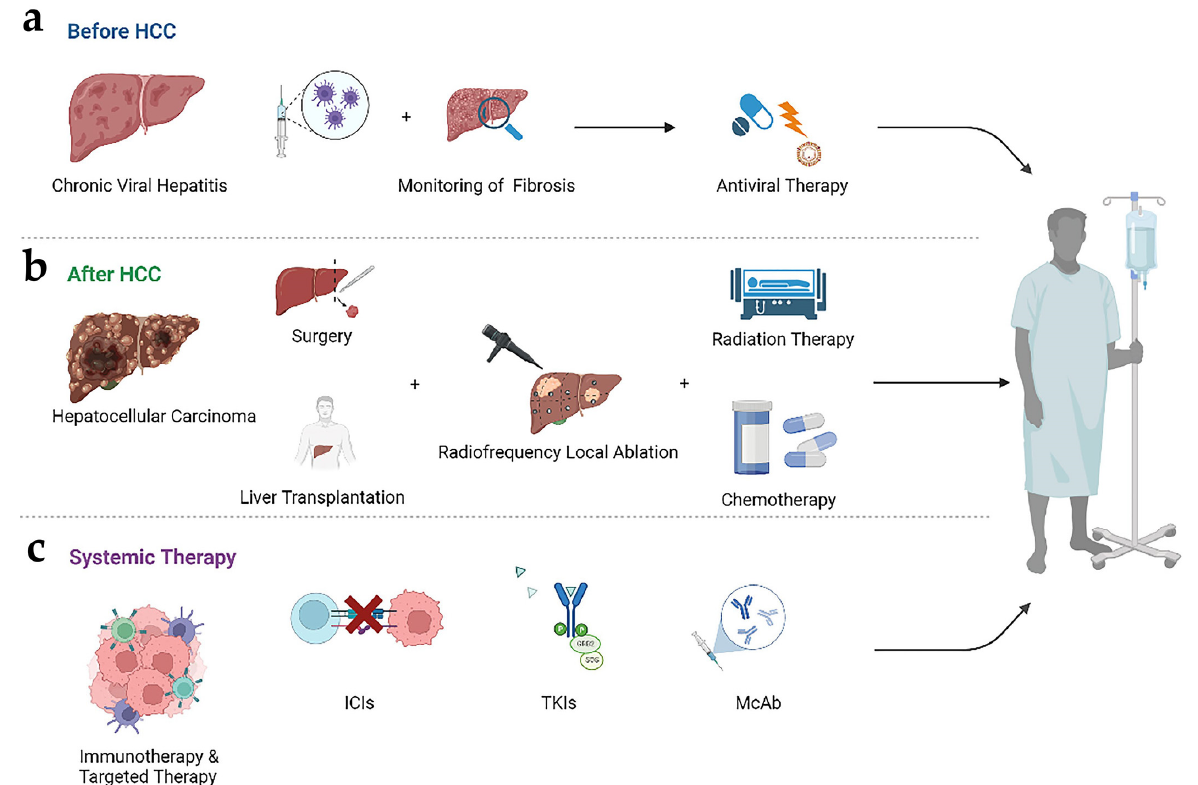
Figure 3. Management and treatment of HBV-induced HCC. ( a ) The main measures before HCC are active HBV vaccination and the continuous detection of the progression of liver fibrosis. For patients with chronic HBV infection, antiviral therapy should be actively carried out to prevent the further development of viral hepatitis. Chronic HBV infection refers to an HBV-positive test, the course of the disease being more than half a year or the onset date not being clear, and clinical manifestations of chronic hepatitis [94]; ( b ) The treatment of HCC includes surgical and non-surgical methods. The surgery includes liver resection and liver transplantation. Non-surgical methods include radiofrequency local ablation, chemotherapy, and radiotherapy [88]; ( c ) Systemic therapies, including immune checkpoint inhibitors (ICIs), tyrosine kinase inhibitors (TKIs), monoclonal antibodies (McAbs) and other targeted molecular drugs, can better achieve personalized treatment, especially to improve the survival rate of advanced patients who cannot be treated with surgery. The image material is referenced from Biorender [2].